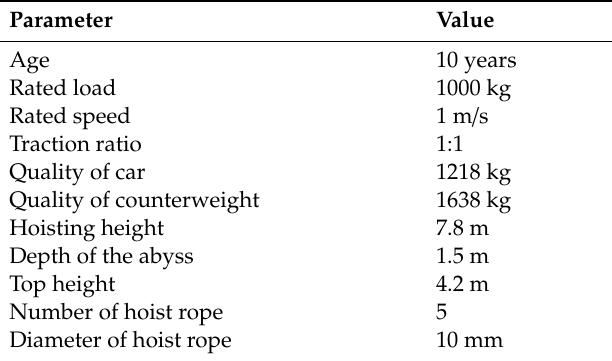
Table 2. Performance parameters of elevator.